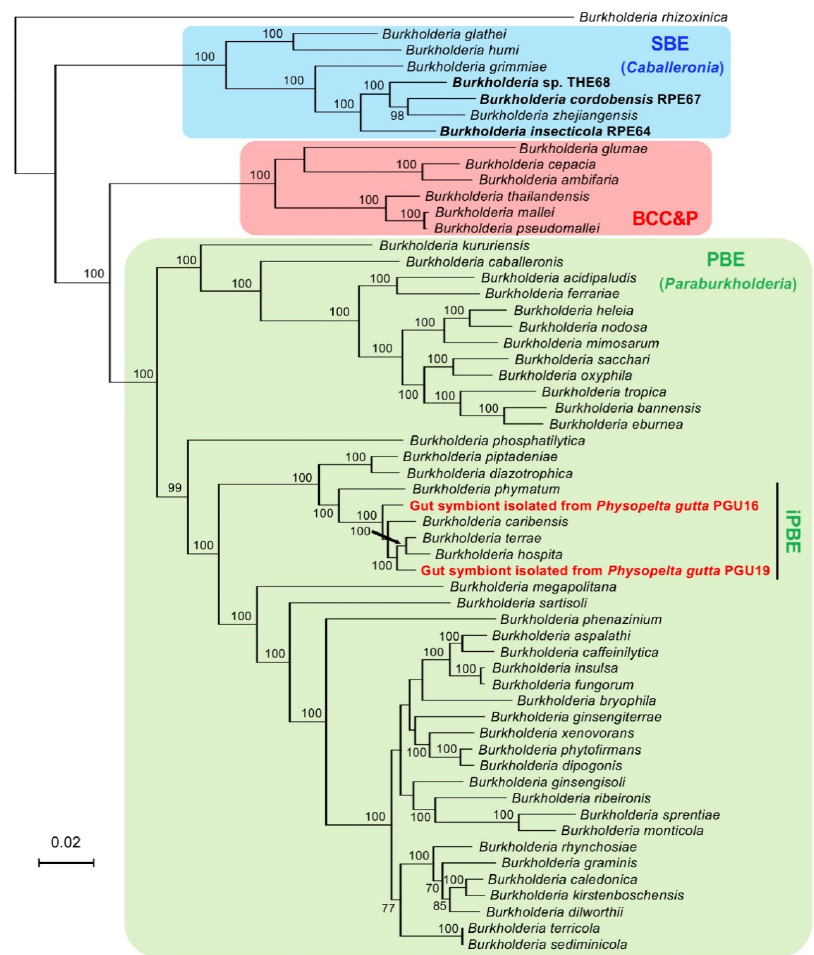
Figure 4. Genome-based molecular phylogeny of the Burkholderia symbionts isolated from P. gutta. The tree shows an ML phylogeny of the two isolates and related species of the genus Burkholderia sensu lato. The multiple sequence alignment of 22,112 amino acids of the 70 UBCGs was analyzed. Accession numbers in the DDBJ/EMBL/GenBank DNA database are shown in Table S2. Isolates of the symbiotic Burkholderia derived from the largid stink bug are shown in red. Bold indicates the Burkholderia symbionts of stink bugs. Bootstrap support values higher than 70% are shown on the internal branches. BCC&P, B. cepacia complex and B. pseudomallei clade; SBE, stink